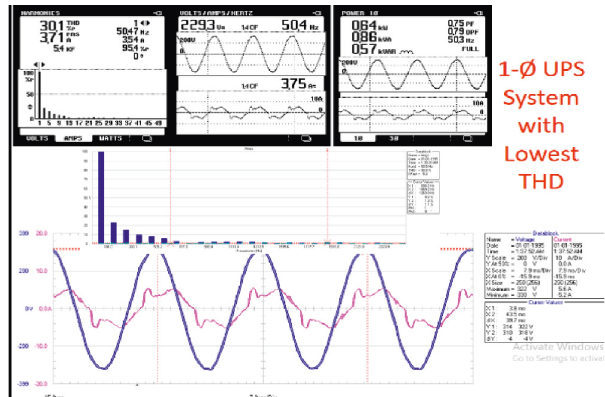
Figure 11: Experimental single-phase UPS system waveforms of voltage, current, and the frequency spectrum of harmonics with the lowest THD.